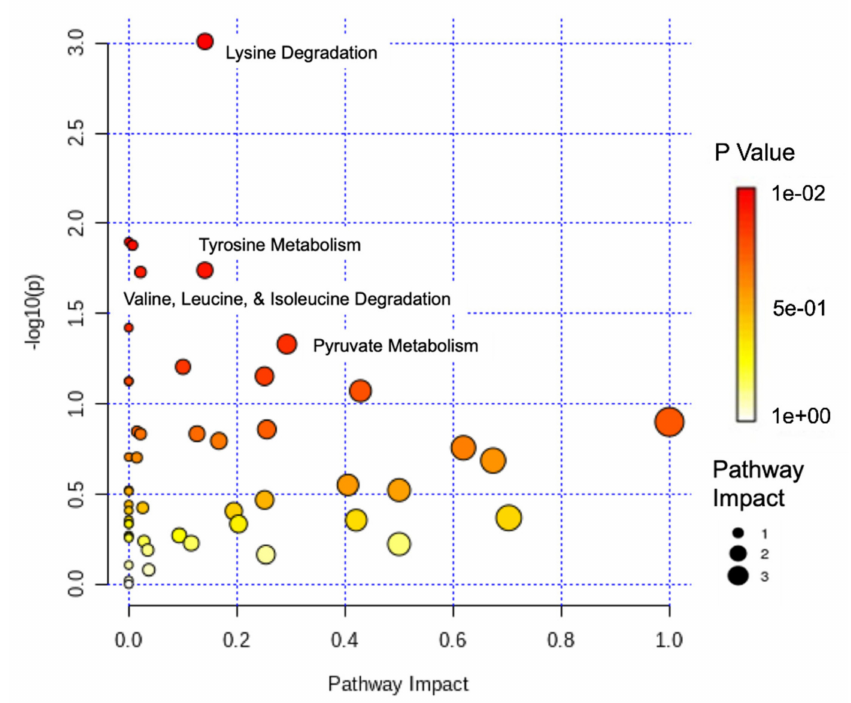
Figure 1. Log-transformed pathway analysis of sex and the metabolome. Data is plotted as signifi- cance ( − log 10 ( p )) versus pathway impact.